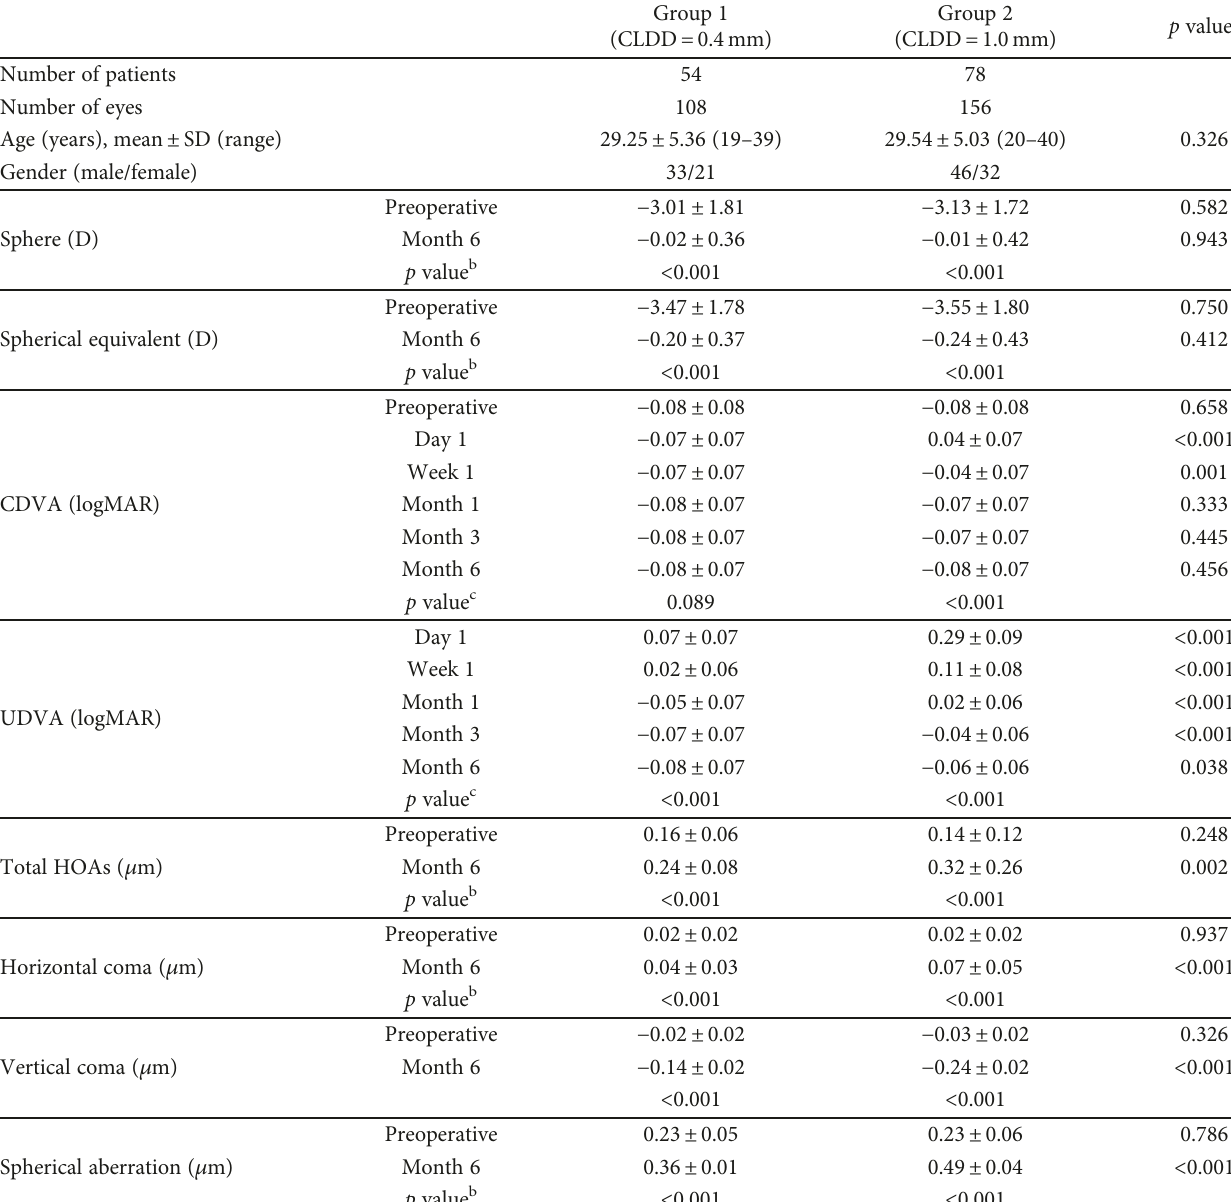
Table 1: Demographic and ocular fi ndings of the study groups throughout the